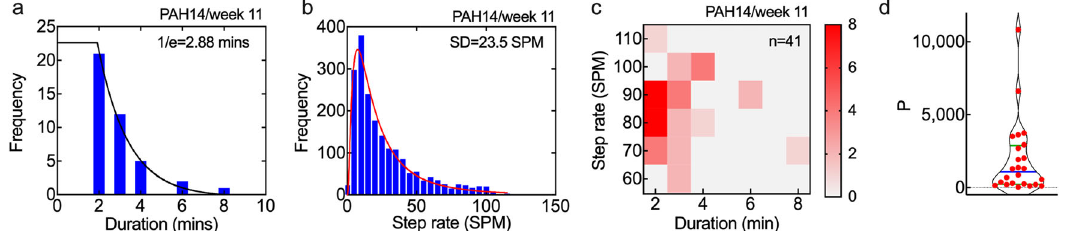
Fig. 4 Ambulation metrics. Representative ambulation metrics for PAH 14 in week 11. a Frequency of weekly ambulations of ≥ 2 min with sustained SR ≥ 60 SPM. Endurance was de fi ned by the 1/e value of an exponential fi t to the histogram. b Ambulation intensity was de fi ned by the standard deviation of the step rate distribution. c Heat map showing ambulation frequency on a plot of step rate versus ambulation duration. d Violin plot showing average values of ambulation product P ( = frequency × endurance × intensity) for all subjects. Blue bar – mean; green bars – upper and lower quartiles.